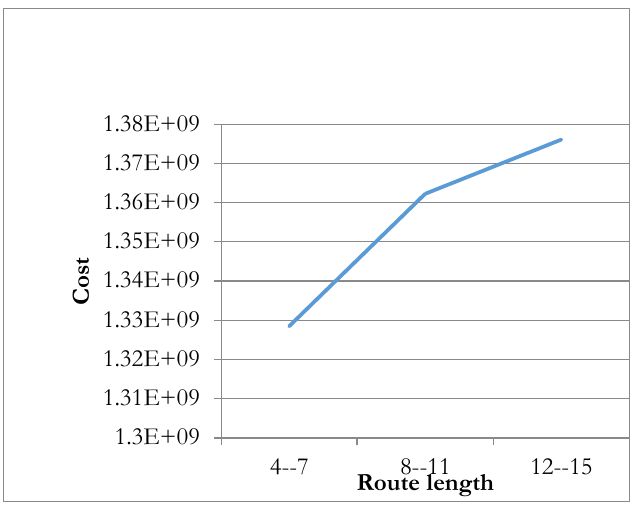
Fig. 9. Analysis of the effect of discharge route length on